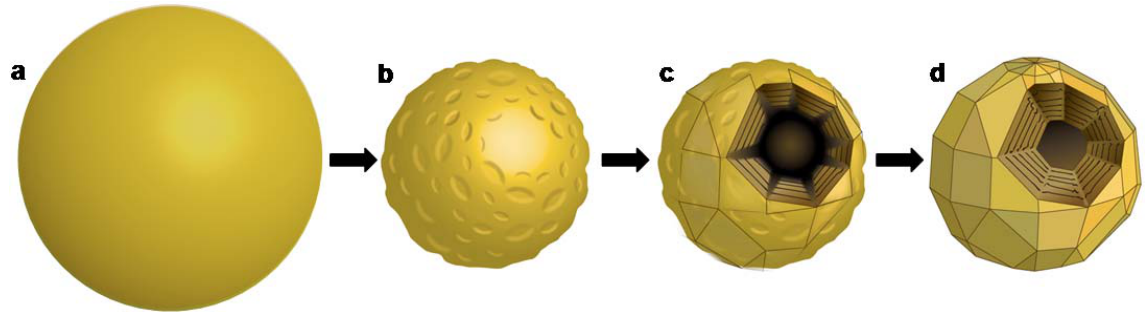
Figure 4. Schematic formation mechanism of NIF-V Amorphous V O nanoparticle (NP) (c) Partially crystallized amorphous V 2 5 nanoparticle with individual facets growing laterally and radially ( d) Fully crystalline NIF- V O NP with defective domains between 2 5